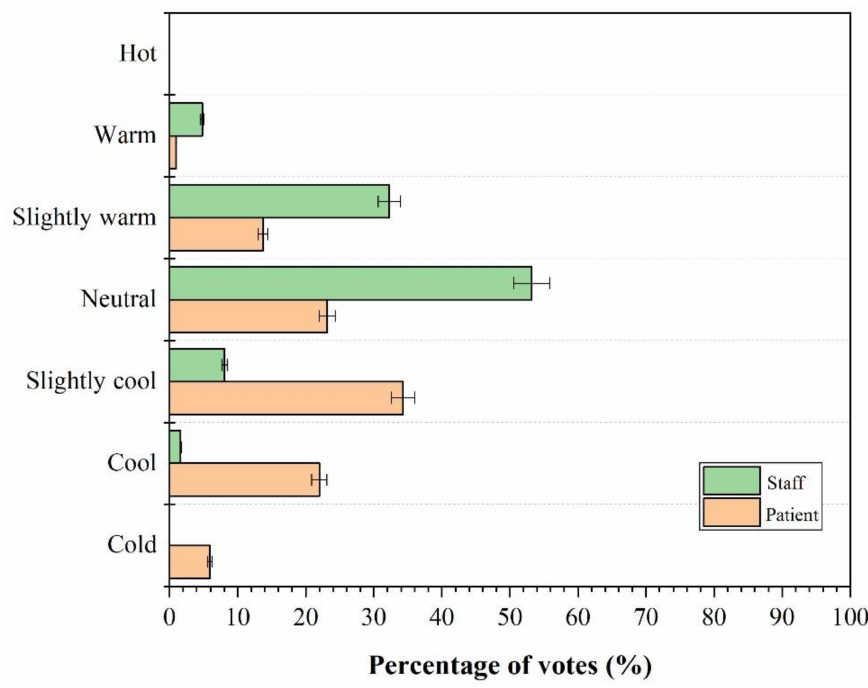
Figure 6. Subjective thermal sensation of patients and healthcare